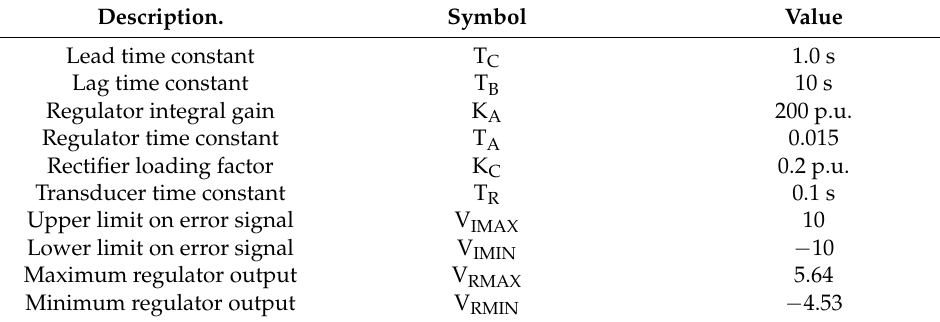
Figure 4. AC4A Exciter type model. Table 4. Excitation system